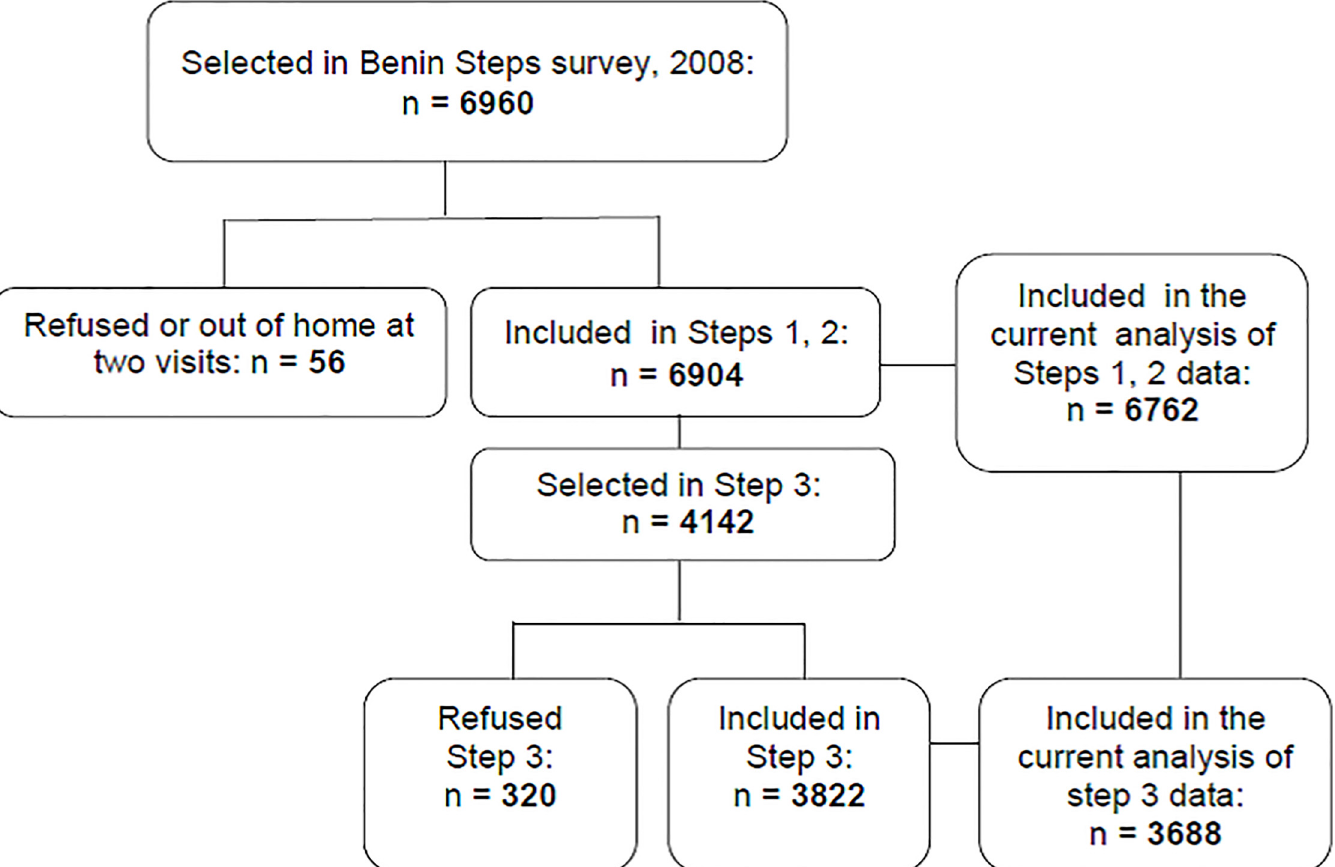
Fig 1. Flow chart of subjects included in Benin Steps survey and in the current analysis. Of 6960 subjects selected in the Benin Steps survey, 6904 participated, 3822 had Step 3 data, 6762 included in the current study 3688 had Step 3 data.